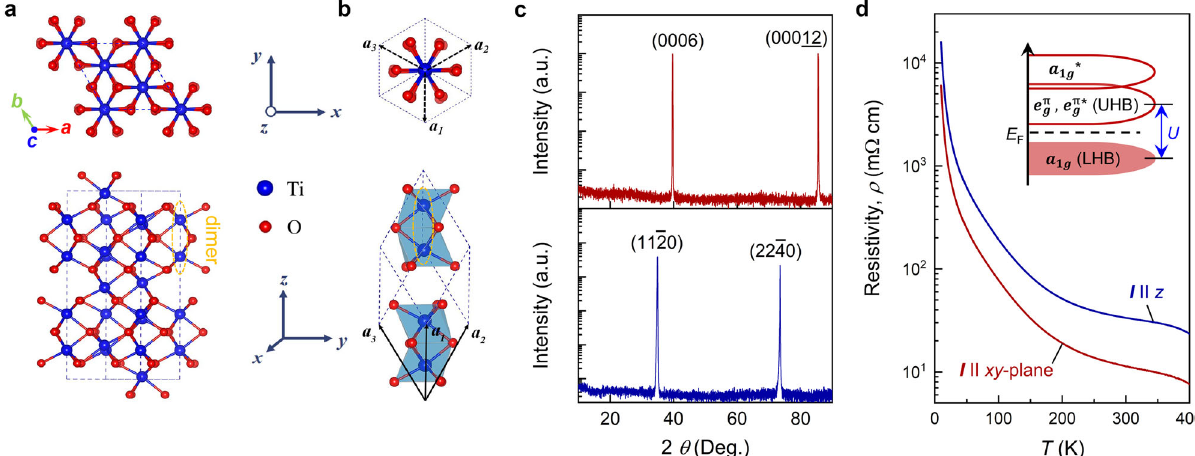
Fig. 1 | Crystal structure and correlated insulating behavior for α -Ti 2 O 3 . Sche- maticviewsofthe a conventionalcelland b unitcellof α -Ti 2 O 3 .Theupperpanelisa topviewandthelowerpanelisalateralview.TiandOatomsarerepresentedbythe blue and red balls, respectively. c HR-XRD patterns for a α -Ti 2 O 3 singlecrystalwith